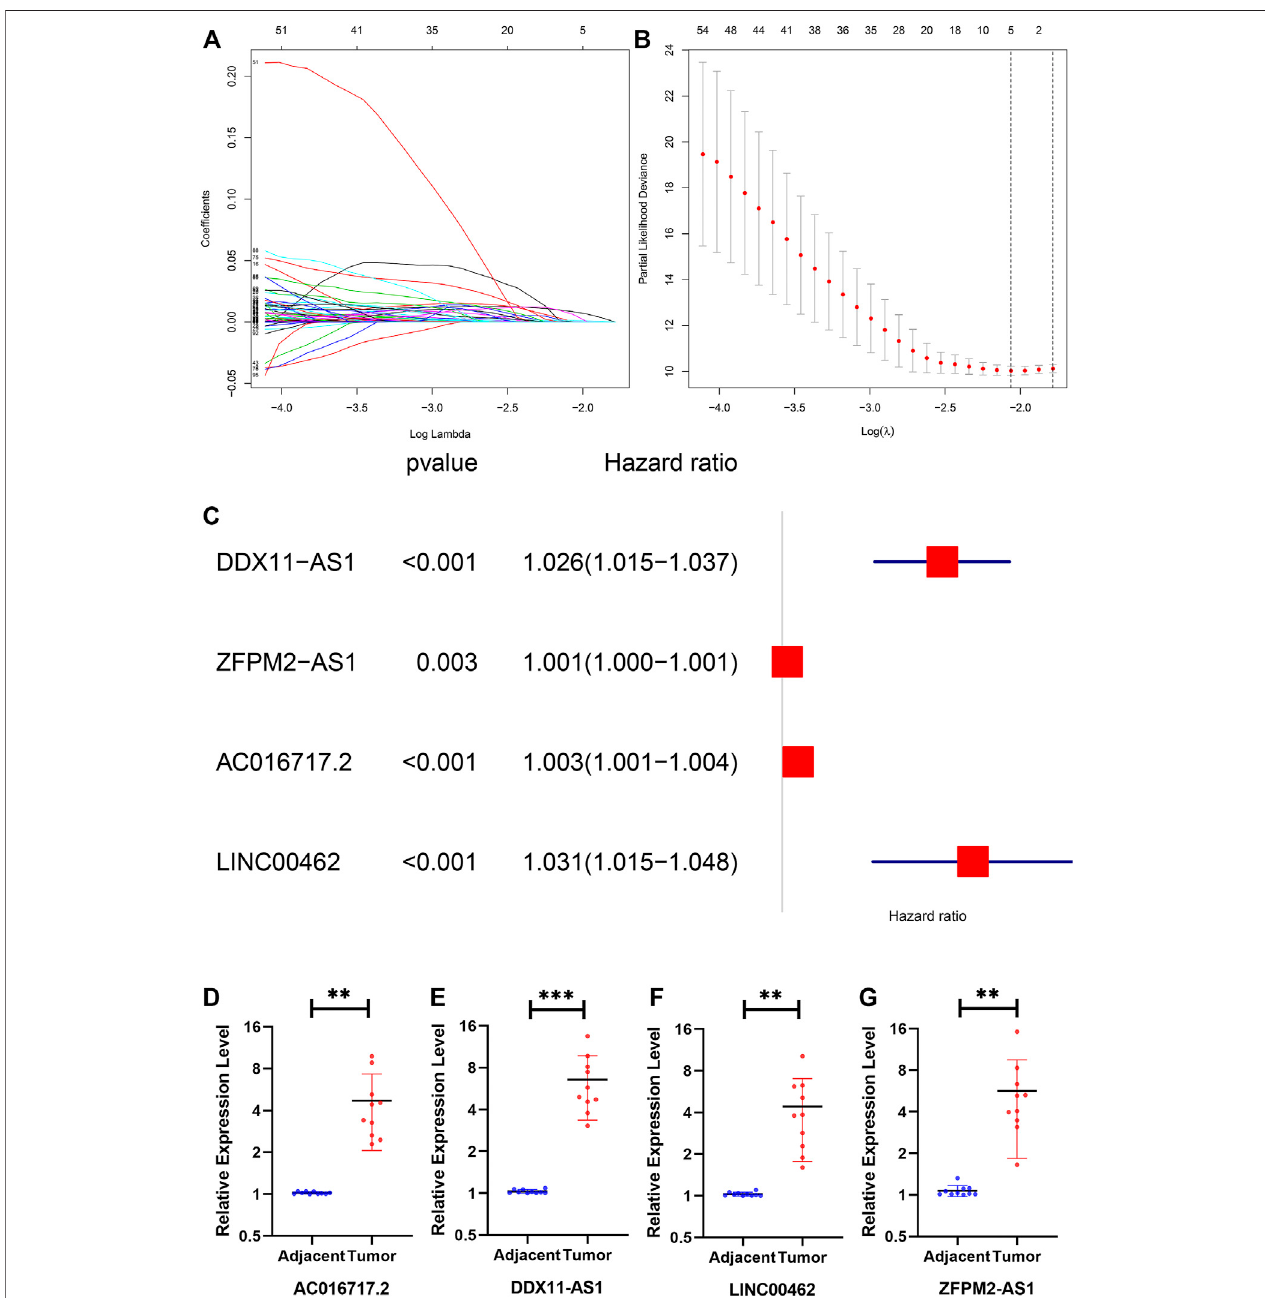
FIGURE3|(A) Thelambda,thecv fi t, (B) theforest (C) theexpressionofDDX11-AS1,ZFPM2-AS1,AC016717.2,andLINC00462intissues.Theexpressionofall genes showed signi fi cant differences in 10